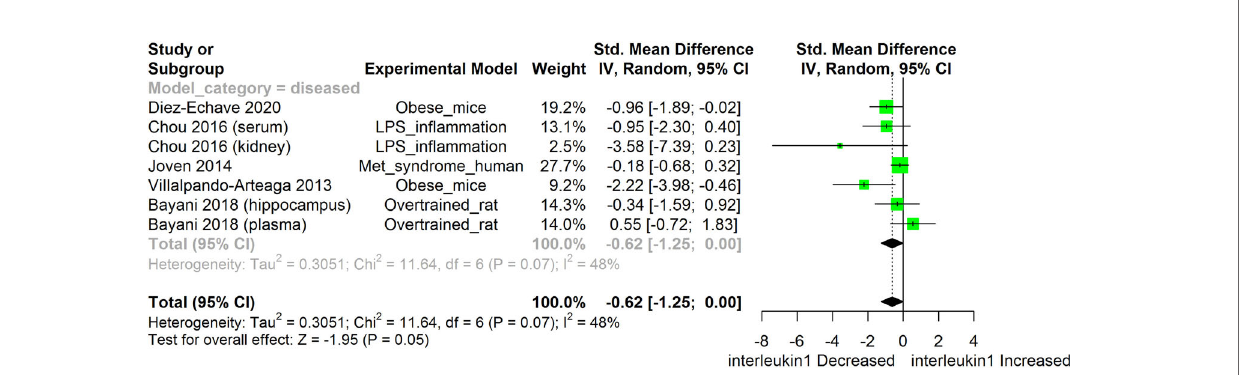
treatment causes an increase in the levels of the biomarker. The statistical signi fi cance of the pooled estimate is indicated by the Z test of signi fi cance. LPS, Lipopolysaccharide; Met, Metabolic.